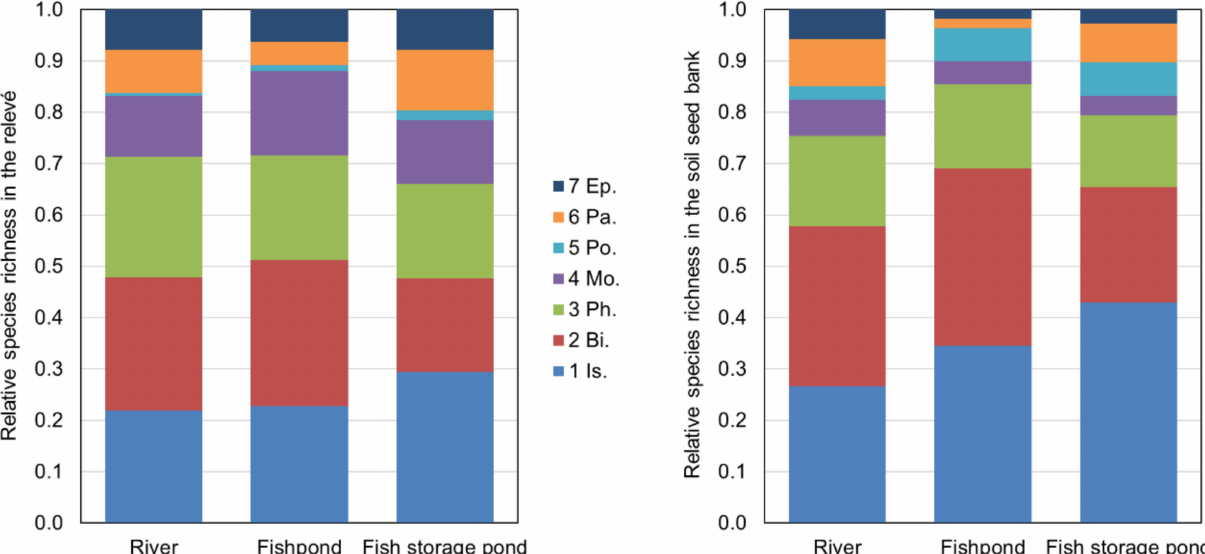
Figure 6. Relative species richness in the relev é and in the corresponding soil seed bank of species groups according to vegetation classes in the three habitat types, rivers ( n = 11), fishponds ( n = 10), and fish storage ponds ( n = 9), based on the species list used for comparison of the relev é with the soil seed bank on the same 1 m 2 plot (Table S3). (1) Isoëto-Nanojuncetea and Crypsietea, (2) Bidentetea, (3) Phragmito-Magnocaricetea and Scheuchzerio-Caricetea, (4) Molinio-Arrhenatheretea and other grassland classes, (5) Potamogetonetea and Lemnetea, (6) Papaveretea and other classes of annual ruderal vegetation, and (7) Epilobietea and other classes of perennial ruderal